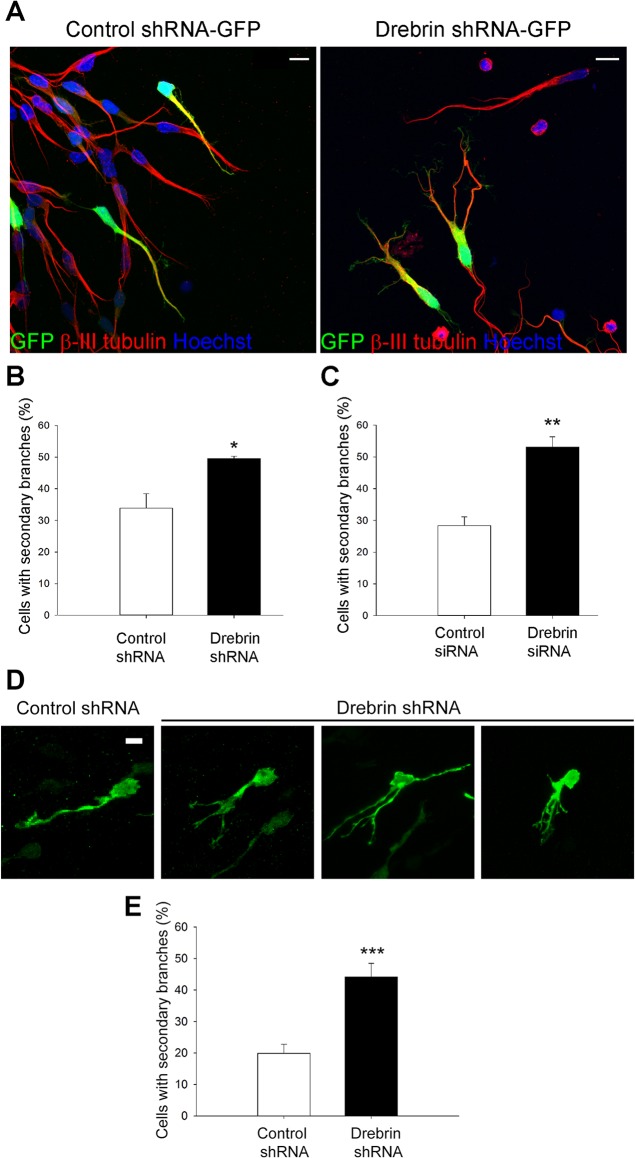
Drebrin knockdown affects neuroblast morphology in vitro.(A) Representative images of rat RMS neuroblasts nucleofected with control (left) or drebrin (right) shRNA-GFP. Note the branched morphology in drebrin shRNA-transfected cells (right, yellow), compared to the unipolar shape of control neuroblasts (left, yellow). (B) shRNA- and (C) siRNA-mediated drebrin depletion significantly increases the percentage of branched cells (mean ± SEM; n = 3 independent experiments; 191 cells analysed for control shRNA, 192 cells for drebrin shRNA; 202 cells for control siRNA, 207 cells for drebrin siRNA; *P<0.05; **P<0.01). (D) P2 mouse pups were electroporated in the lateral ventricle with control or drebrin shRNA-GFP plasmids. Sagittal brain slices containing the RMS were immunostained for GFP 5 days later. Confocal projections showing a typical control cell extending a single process oriented towards the OB, and representative drebrin shRNA-transfected neuroblasts displaying branched protrusions. (E) In vivo postnatal electroporation of drebrin shRNA causes a significant increase in the percentage of branched neuroblasts (mean ± SEM; n = 6 brains per condition, 400 cells analysed for control shRNA and 303 cells analysed for drebrin shRNA; ***P<0.001). Scale bars: (A), 10 μm; (D), 5 μm.